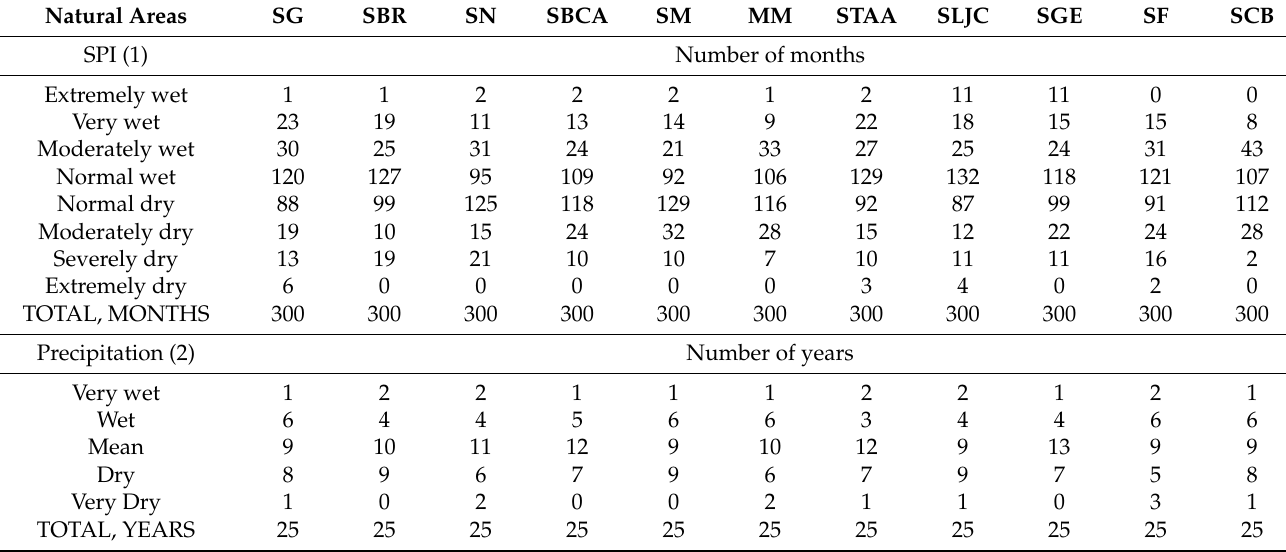
Table 8. Frequency of SPI values and annual